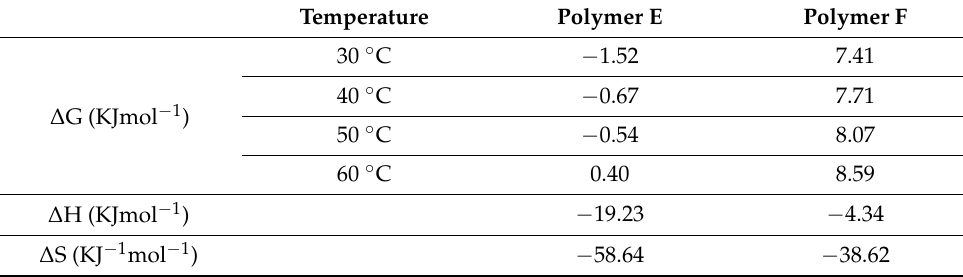
Figure 8. Effect of temperature and Van’t Hoff plot on q e of polymer F ( A ) and polymer E ( B ) for MB adsorption. Experimental conditions were: MB concentration: 100 mg/L; adsorbents hydrogel dose 250 mg in 25 mL; pH 7. Table 3. Polymers E and F thermodynamic parameters for MB adsorption.